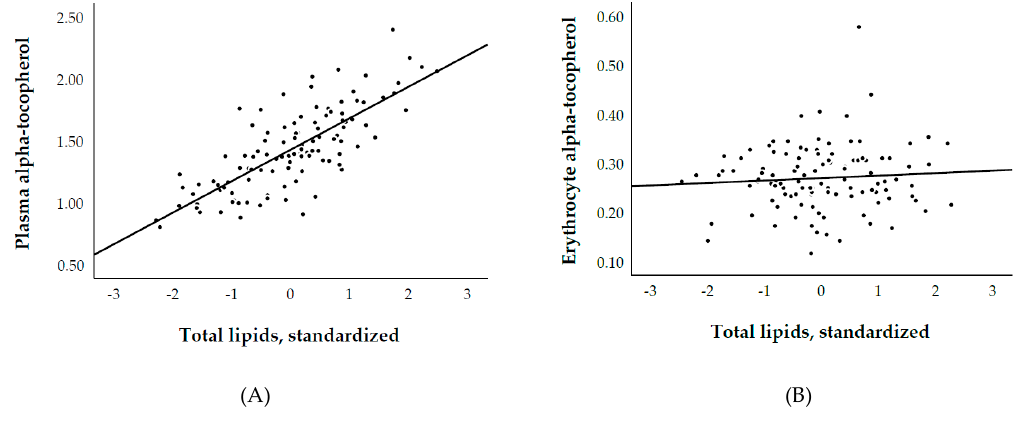
Figure 1. Association of (A) plasma (R 2 = 0.60) and (B) erythrocyte (R 2 = 0.01) α -tocopherol with total lipids. Plasma and erythrocyte α -tocopherol are expressed in mg/dL and mg/10 13 erythrocytes, respectively.